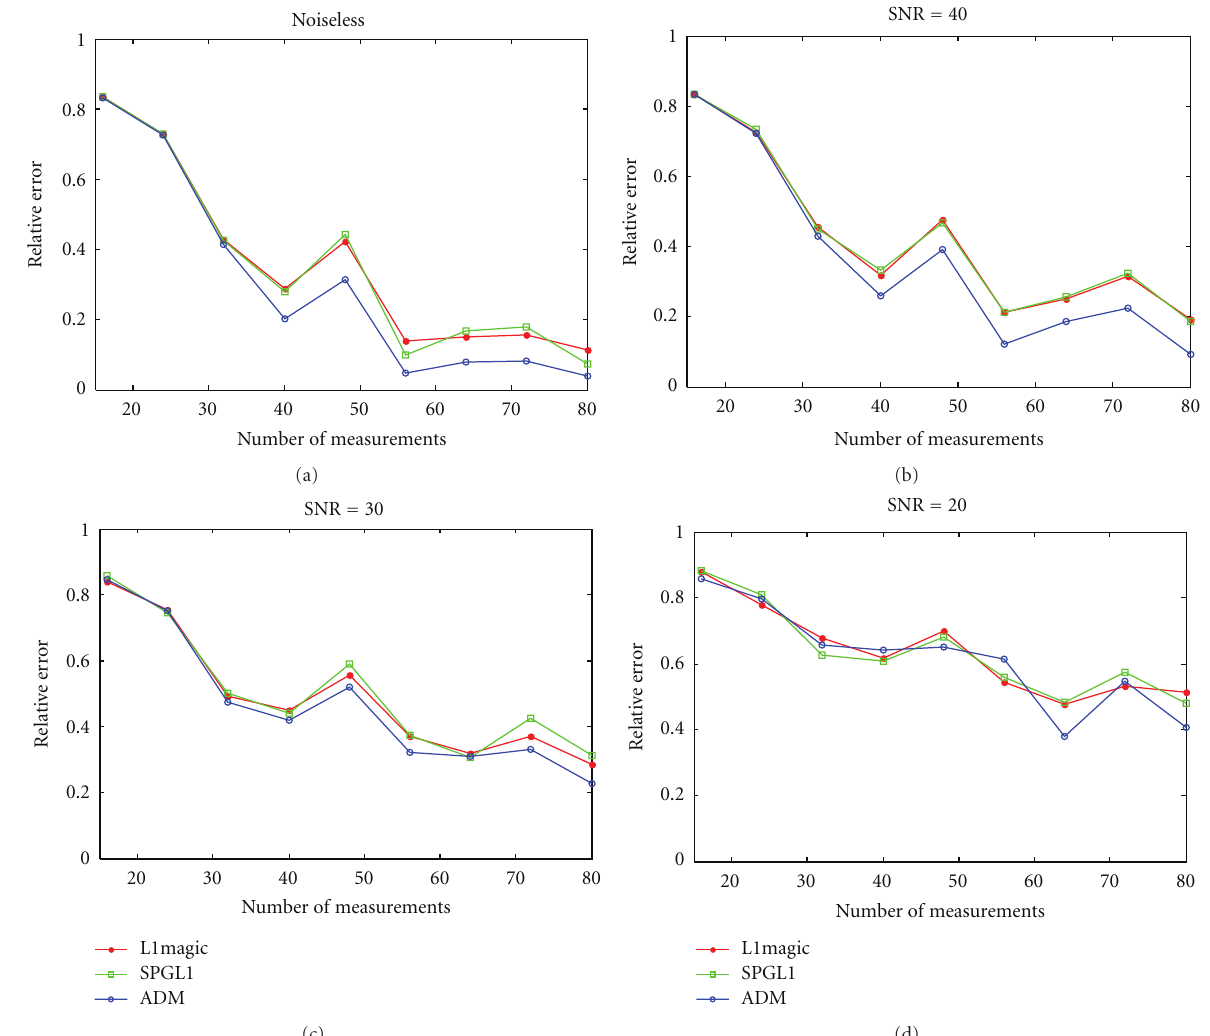
Figure 4: Relative errors for di ff erent CS reconstruction algorithms at di ff erent positions for a uniform distribution at a 90-degree curve. (a) Noiseless observation; noisy observation with (b) SNR = 40 dB; (c) SNR = 30 dB; (d) SNR =